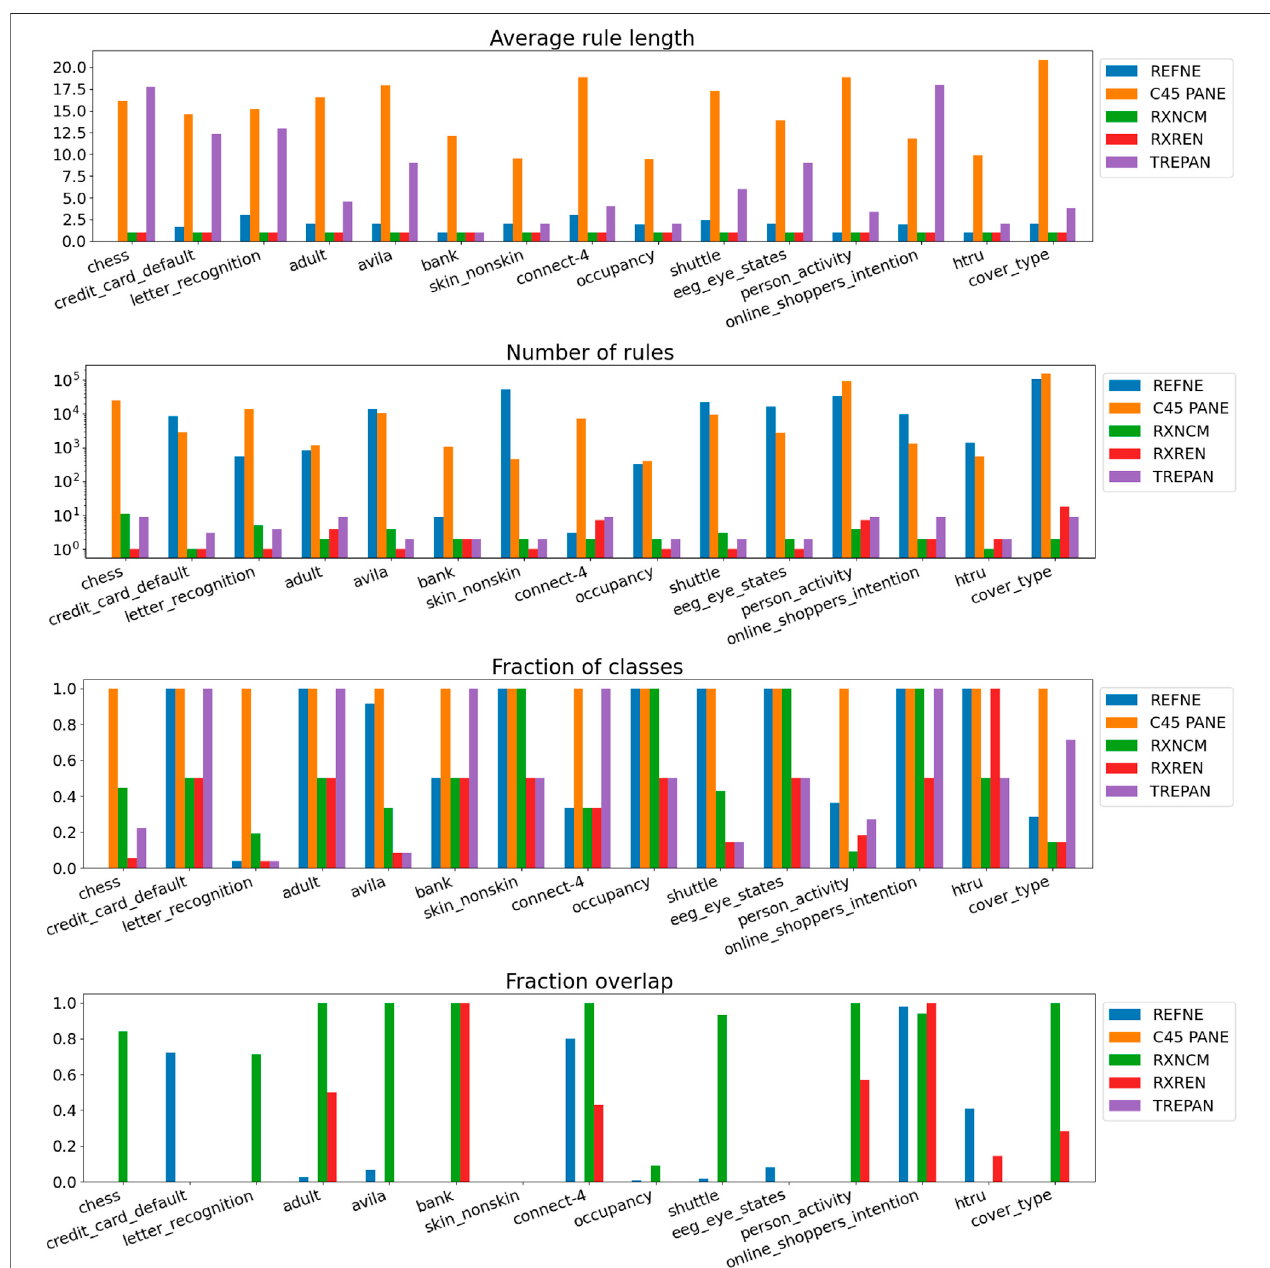
FIGURE5| Quantitativemeasuresofthedegreeofexplainabilityoftherulesetsautomaticallygeneratedby5rule-extractionmethodsover15datasets,groupedby dataset.